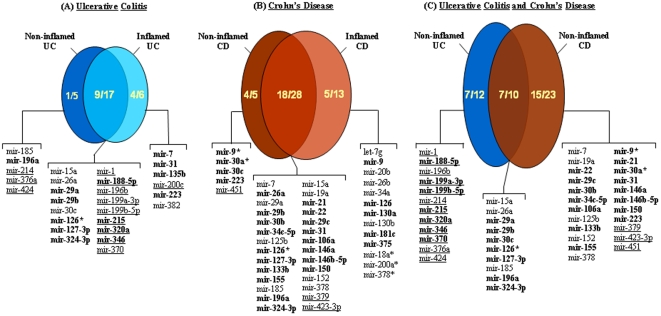
Disease- and stage- specific alterations of miRNA expression.miRNA expression was measured in non-inflamed and inflamed UC and CD tissues and computed vs. that measured in healthy controls. The total numbers of miRNAs that were underexpressed and overexpressed in non-inflamed (dark-colored ovals) or inflamed (light-colored ovals) IBD tissues, as well as those that were commonly altered in both states of the disease (intersect between light and dark-colored ovals) were determined. UC (A) or CD (B) tissues were considered independently. (C) miRNAs that were underexpressed and overexpressed in non-inflamed UC (dark-blue) or non-inflamed CD (dark-red), as well as those that were commonly altered in both diseases (intersect between ovals) were determined. Underexpressed miRNAs are underlined. Bolded characters, miRNA with statistically significant dysregulation of expression relative to healthy controls (p≤0.05).